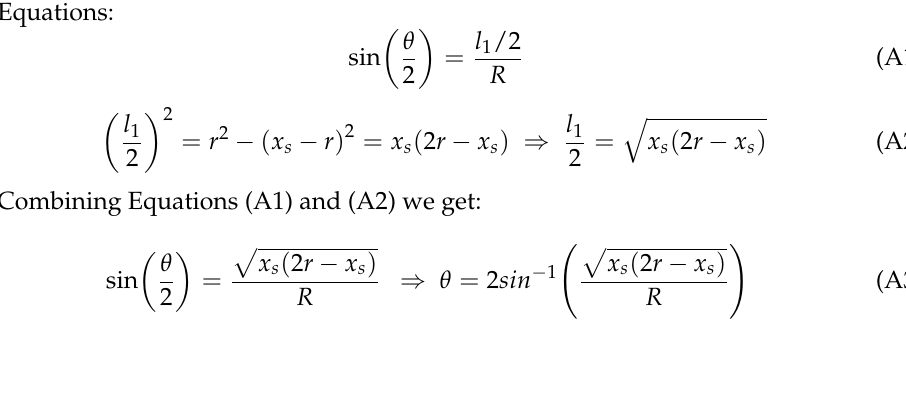
Figure A1. Geometrical details of the notch on spool land. From Figure A1, the expression for θ as a function of x s is derived below.